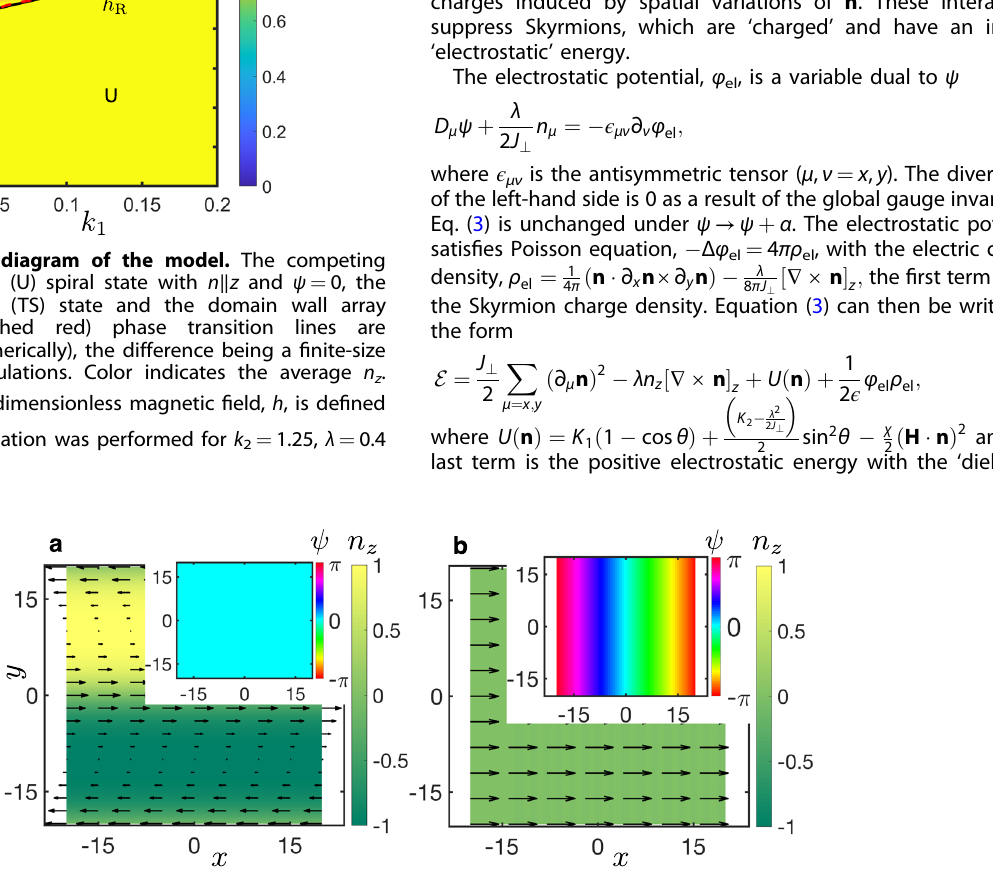
Fig. 4 Modulated states induced by H ∥ x . a The domain wall array, in which the angle θ rotates in the xz plane along the y -axis normal to the fi eld vector. b The ‘ tilted spiral ’ state with n ∥ H and ψ varying along the fi eld direction. The fi gures show the vector chirality n and the corresponding angle ψ is shown in the insets. In-plane components of n are indicated with arrows; n z and ψ are